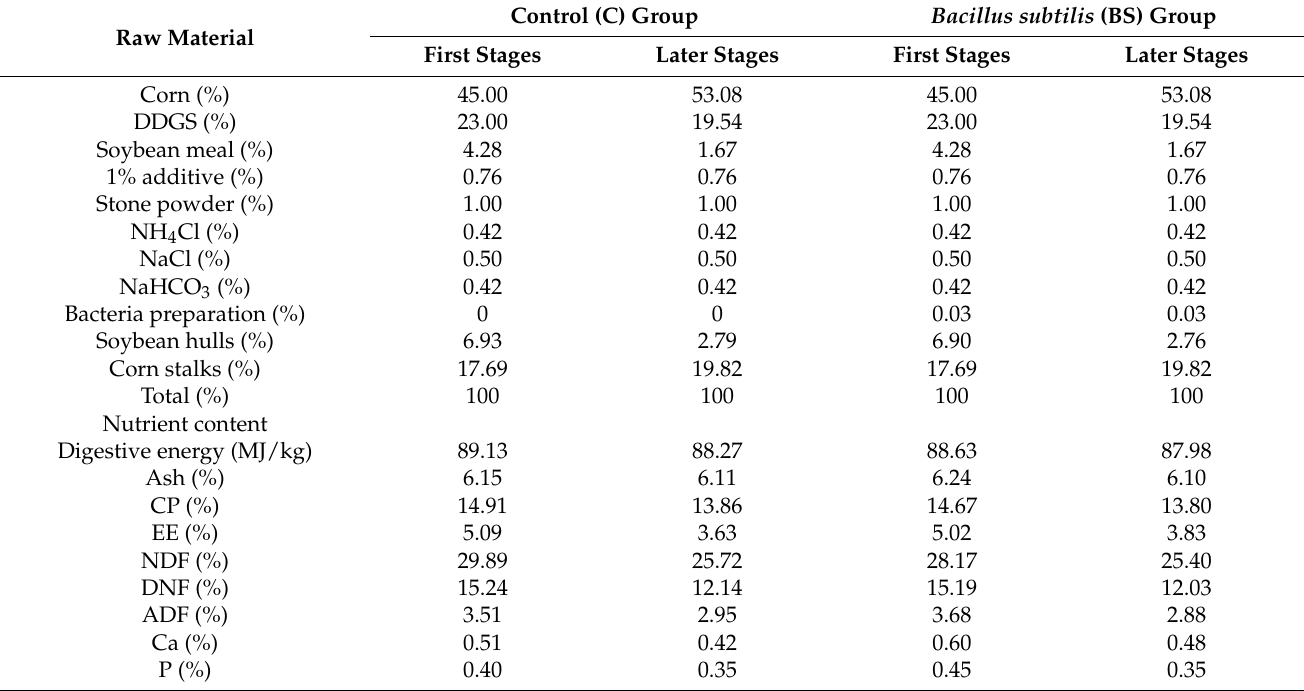
Table 1. Ingredients and nutrient composition of the diet fed to the